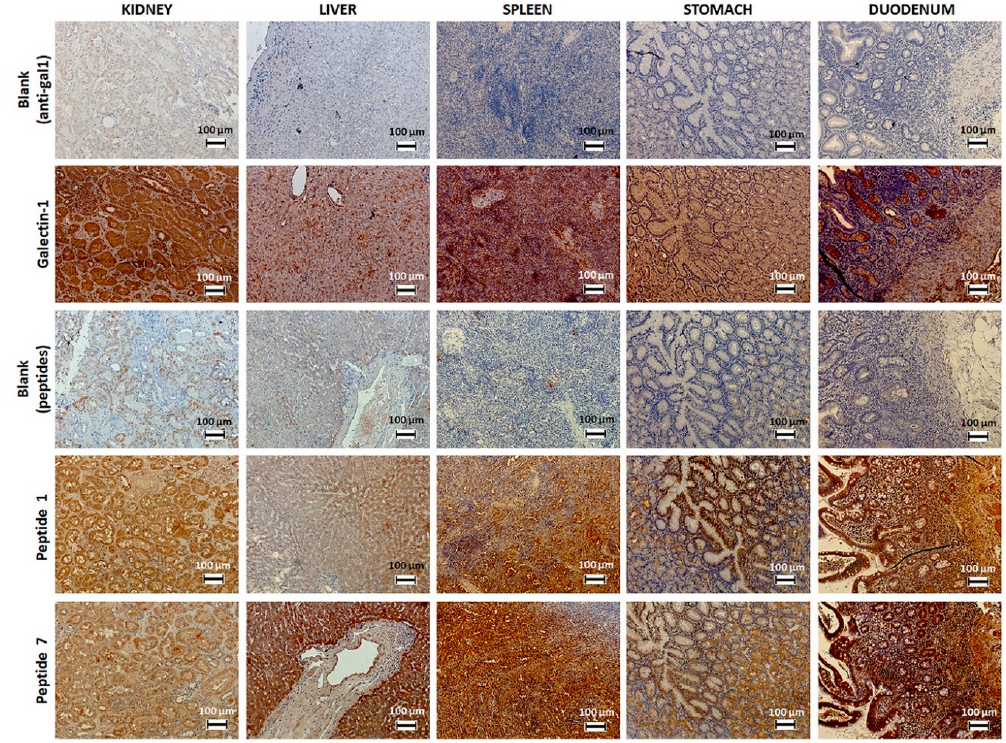
Figure 1. Immunostaining of gal-1 in various human healthy organs using biotinylated peptides 1 7 or anti-gal-1 antibody. and 7 or anti-gal-1 antibody.